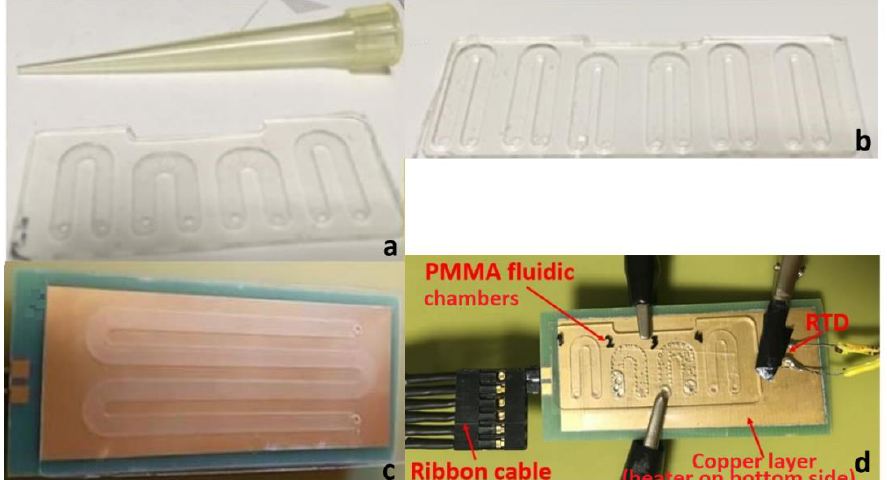
Figure 1. ( a ) Poly(methyl methacrylate) PMMA fluidic chip with 4 u-shaped chambers; ( b ) PMMA fluidic with 6 u-shaped chambers; ( c ) PMMA fluidic chip on top of a thin printed circuit board (PCB) microheater with an external temperature-homogenizing copper layer; ( d ) Experimental set-up for temperature measurements during thermocycling of a static micro polymerase chain reaction (microPCR) chip.